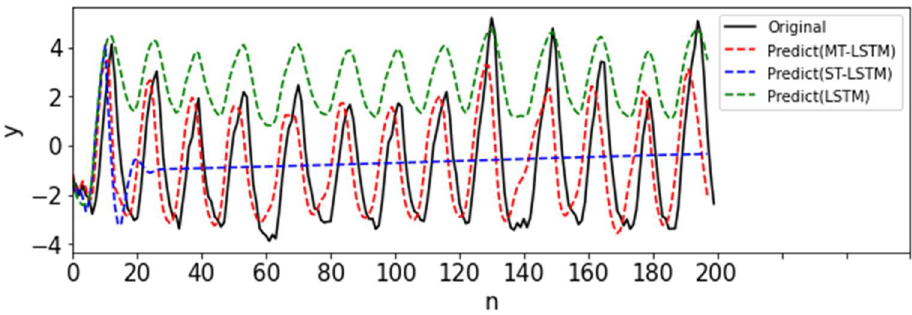
Figure 7. Imputation results of MTGP and STGP for S3.